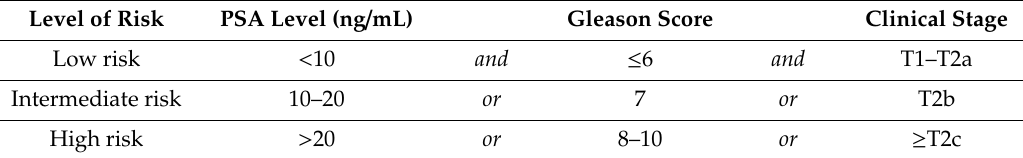
National Institute for Health and Care Excellence. PSA stands for Prostate-Specific